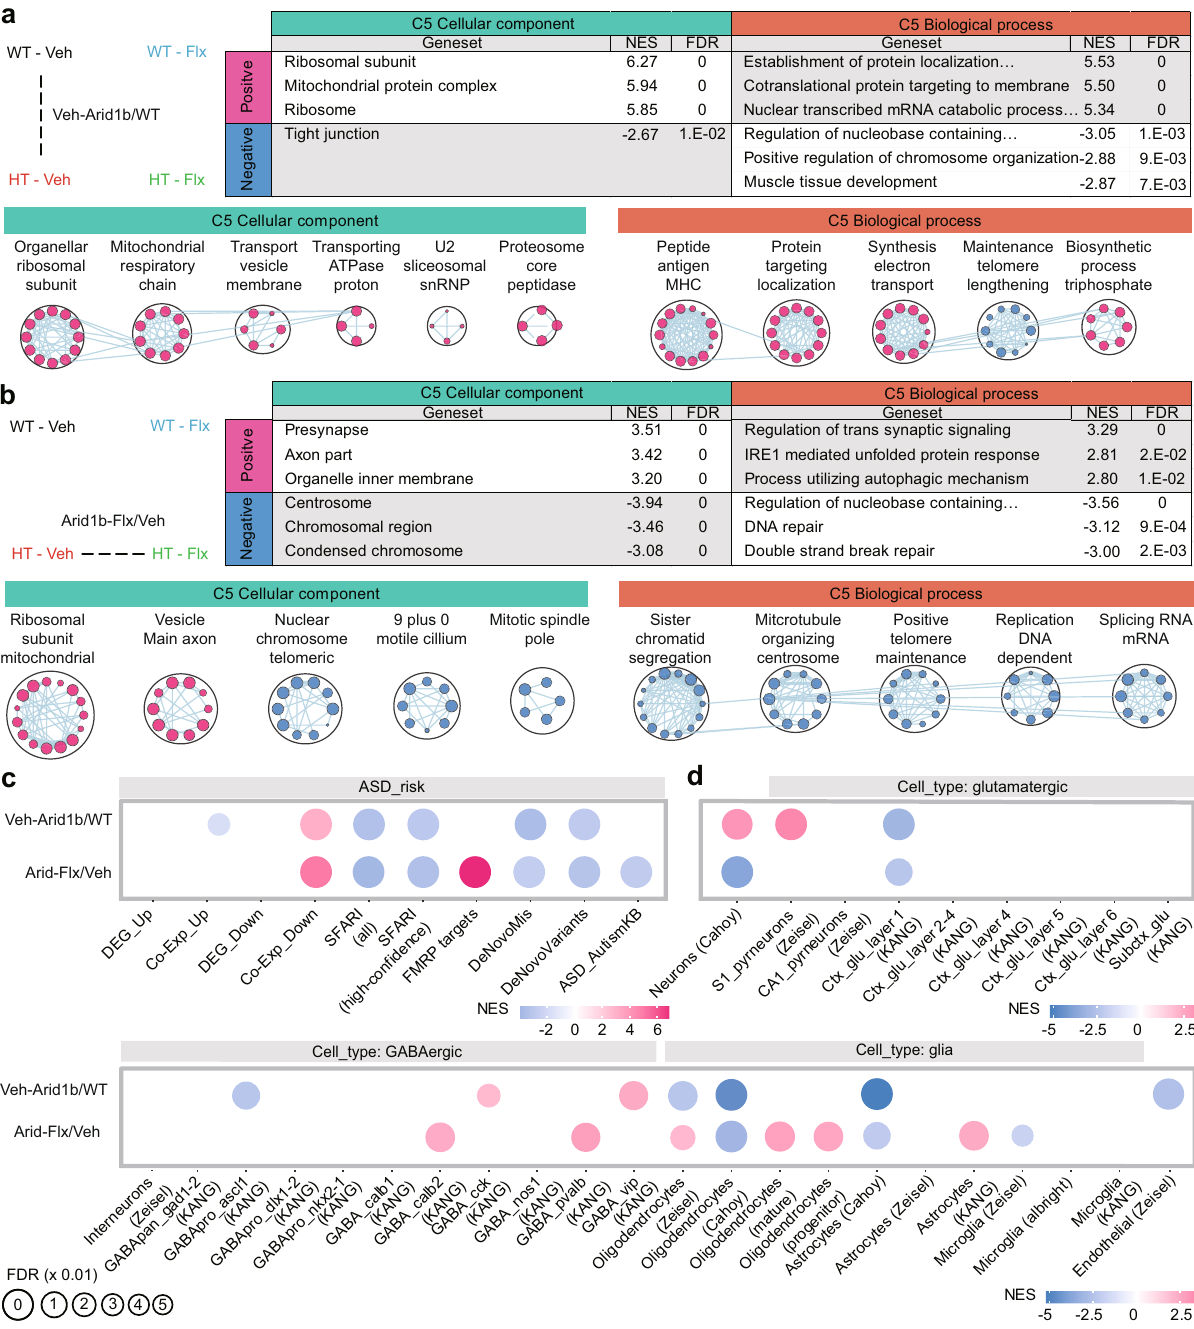
Fig. 6 | Early, chronic fl uoxetine treatment prevents aberrant transcriptomic changes in the whole brain of adult Arid1b +/ – mice. a Baseline differences in whole-brain Arid1b/WT transcripts associated with biological functions in early vehicle-treated(P3 – 21) mice, measured in whole-brain lysates atP120 (Veh-HT/WT transcripts),asshownbythe top-three enrichedgene-setlistsfromGSEAusing C5- CC and C5-BP gene sets and EnrichmentMap integration and visualization of enri- ched gene sets. NES normalized enrichment score; FDR false discovery rate. ( n =5 mice [WT-Veh], 5 [HT-Veh], 5 [WT-Mem], 5 [HT-Mem]). b Transcriptomic changes associatedwithbiologicalfunctionsinducedbyearly,chronic fl